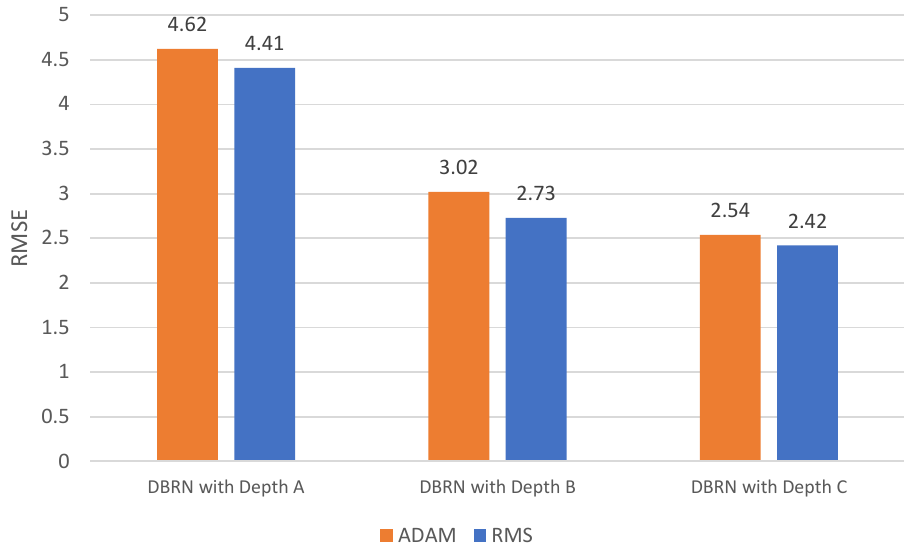
Figure 7. The achieved RMSE values with our proposed DCRN with three architectures depths A, B, and C.